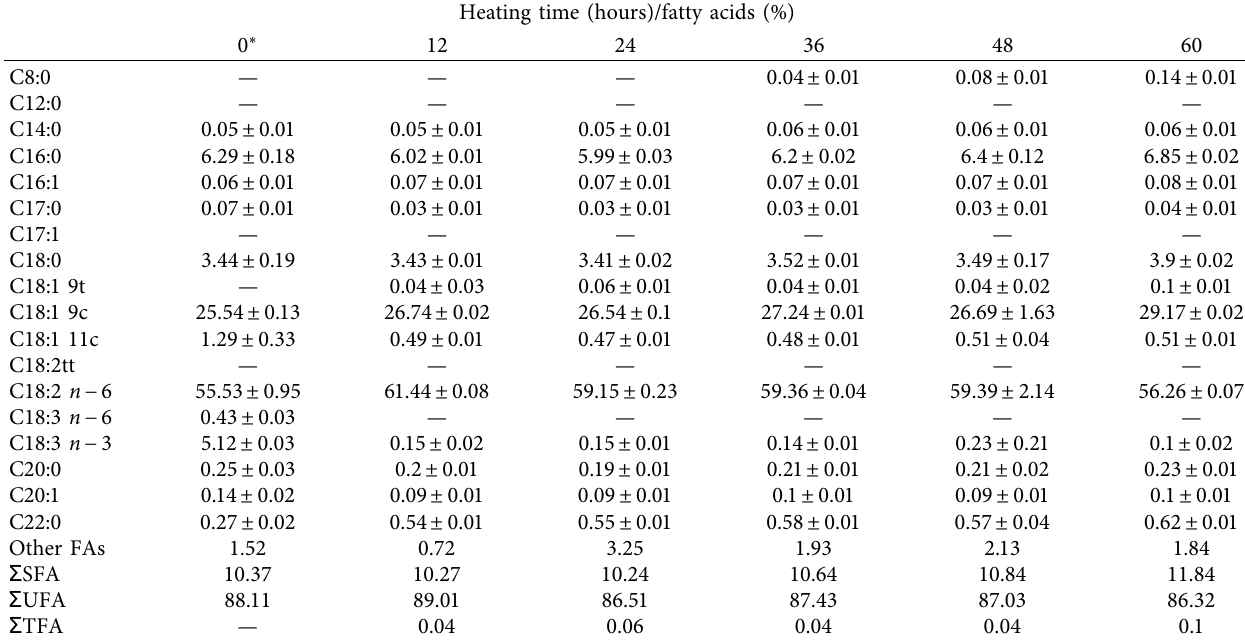
Table 7: Variation of fatty acids of sunflower oil under 180 ° C heating temperature at different heating times. Heating time (hours)/fatty acids (%)